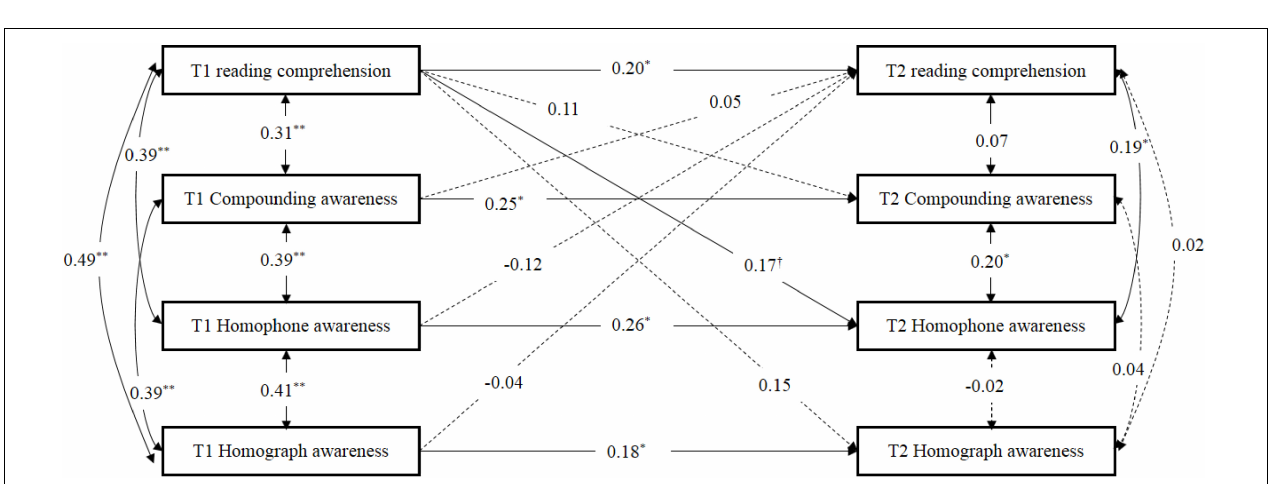
FIGURE 1 | The model to evaluate the longitudinal relationships between compounding awareness, homophone awareness, homograph awareness, and reading comprehension from Grade 1 to 2, after controlling for IQ, rapid number naming, phonological awareness, word reading, and vocabulary knowledge at the initial level. T1, spring of first Grade; T2, spring of second Grade. Dashed lines indicate non-significant paths. The control variables are not shown here to simplify the representation of the model. ∗ p < 0.05, ∗∗ p < 0.01, two- tailed.